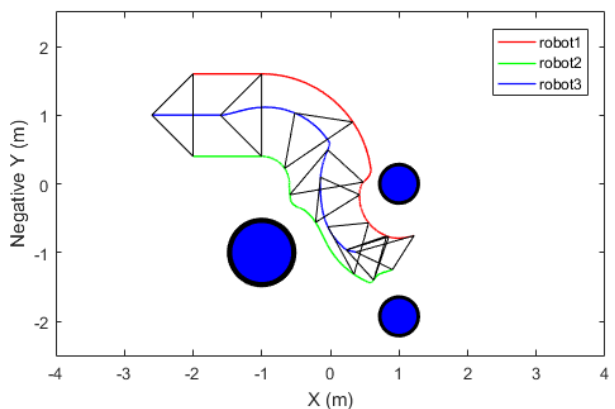
Figure 12. The formation tracking performance for robots in formation with C1–P1.